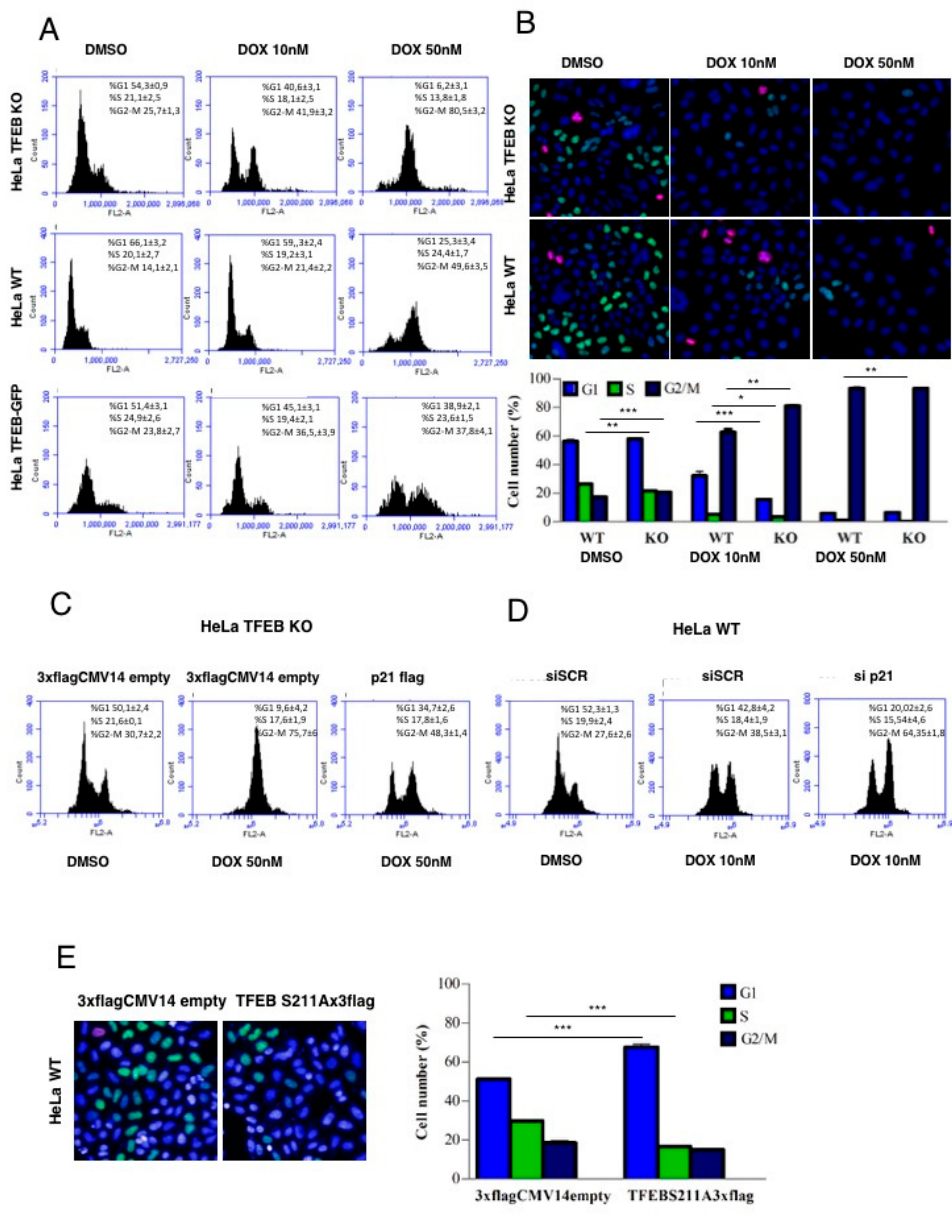
Figure 4. TFEB depletion leads to a faster arrest in the G2 phase in response to DNA damage. ( A ) Representative histograms showing flow cytometry analysis of cell cycle in HeLa WT compared with HeLa TFEB KO and HeLa TFEB-GFP after the treatment with doxorubicin (10 nM and 50 nM) for 24 h. ( B ) High Content Imaging analysis of the percentage of cells in G1, S, and G2 / M phases in HeLa WT compared with HeLa TFEB KO after the treatment with doxorubicin (10 nM and 50 nM) for 24 h. ( C ) Representative histograms showing flow cytometry analysis of cell cycle in HeLa TFEB KO overexpressing p21 compared with empty vector-transfected cells after the treatment with doxorubicin (50 nM) for 24 h. ( D ) Representative histograms showing flow cytometry analysis of cell cycle in HeLa WT cells transfected with either non-targeting siRNA (siSCR) or p21-targeting siRNA (sip21) for 72 h, and treated with doxorubicin (10 nM) the last 24 h. ( E ) High Content Imaging analysis of the percentage of cells in G1, S, and G2 / M phases in HeLa WT cells transfected with an empty vector or a plasmid encoding TFEB S211A for 24 h. Data are represented as mean ± SEM of three independent experiments * p < 0.05, ** p < 0.01, *** p < 0.001 (two-tailed Student’s